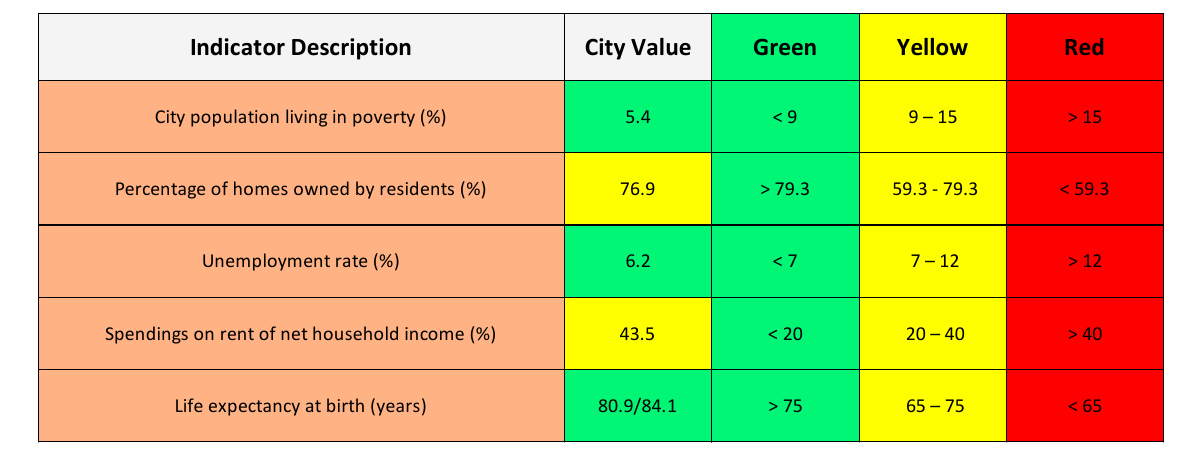
Figure A1. Sample of economy and governance assessed indicators adapted for the project from Morgenstadt.